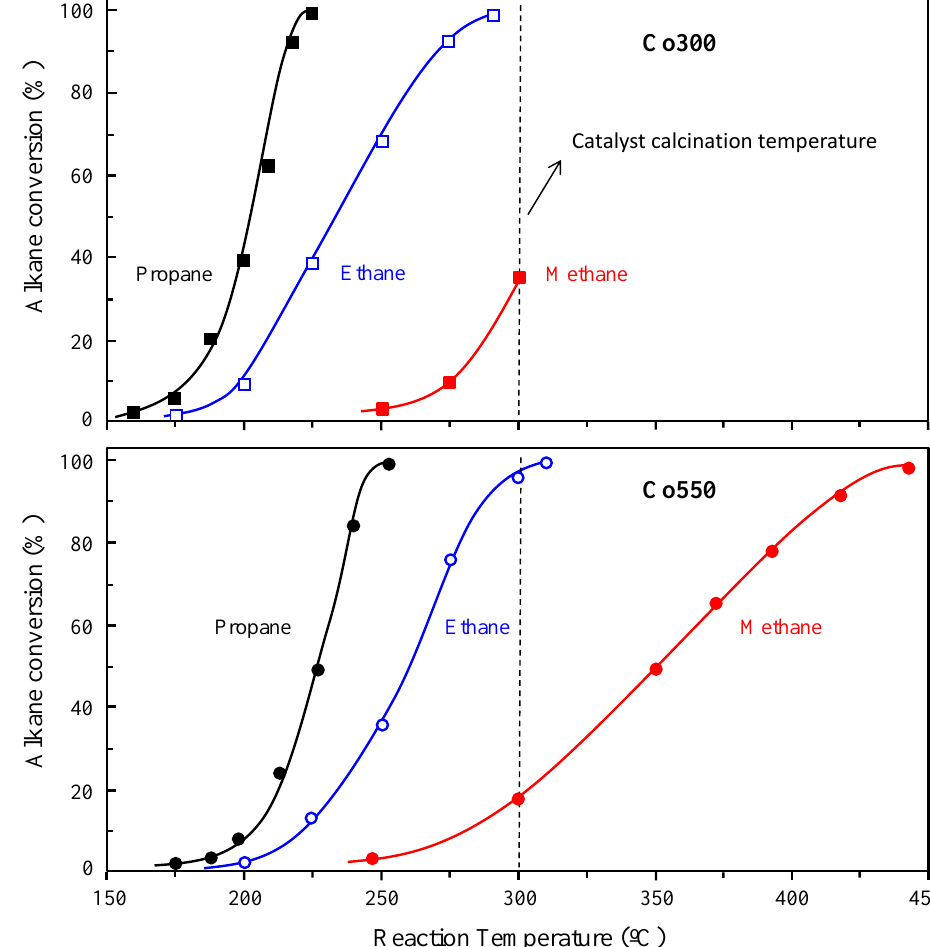
Figure 2. Variations in the alkane (i.e., methane, ethane, or propane) conversion with the reaction temperature in total oxidation catalytic reactions using Co 3 O 4 -based catalysts activated at different calcination temperatures: 300 °C (Co300 catalyst, up) or 550 °C (Co550 catalyst, down). Reaction conditions detailed in the text. Propane (full black), ethane (empty), and methane (full red).